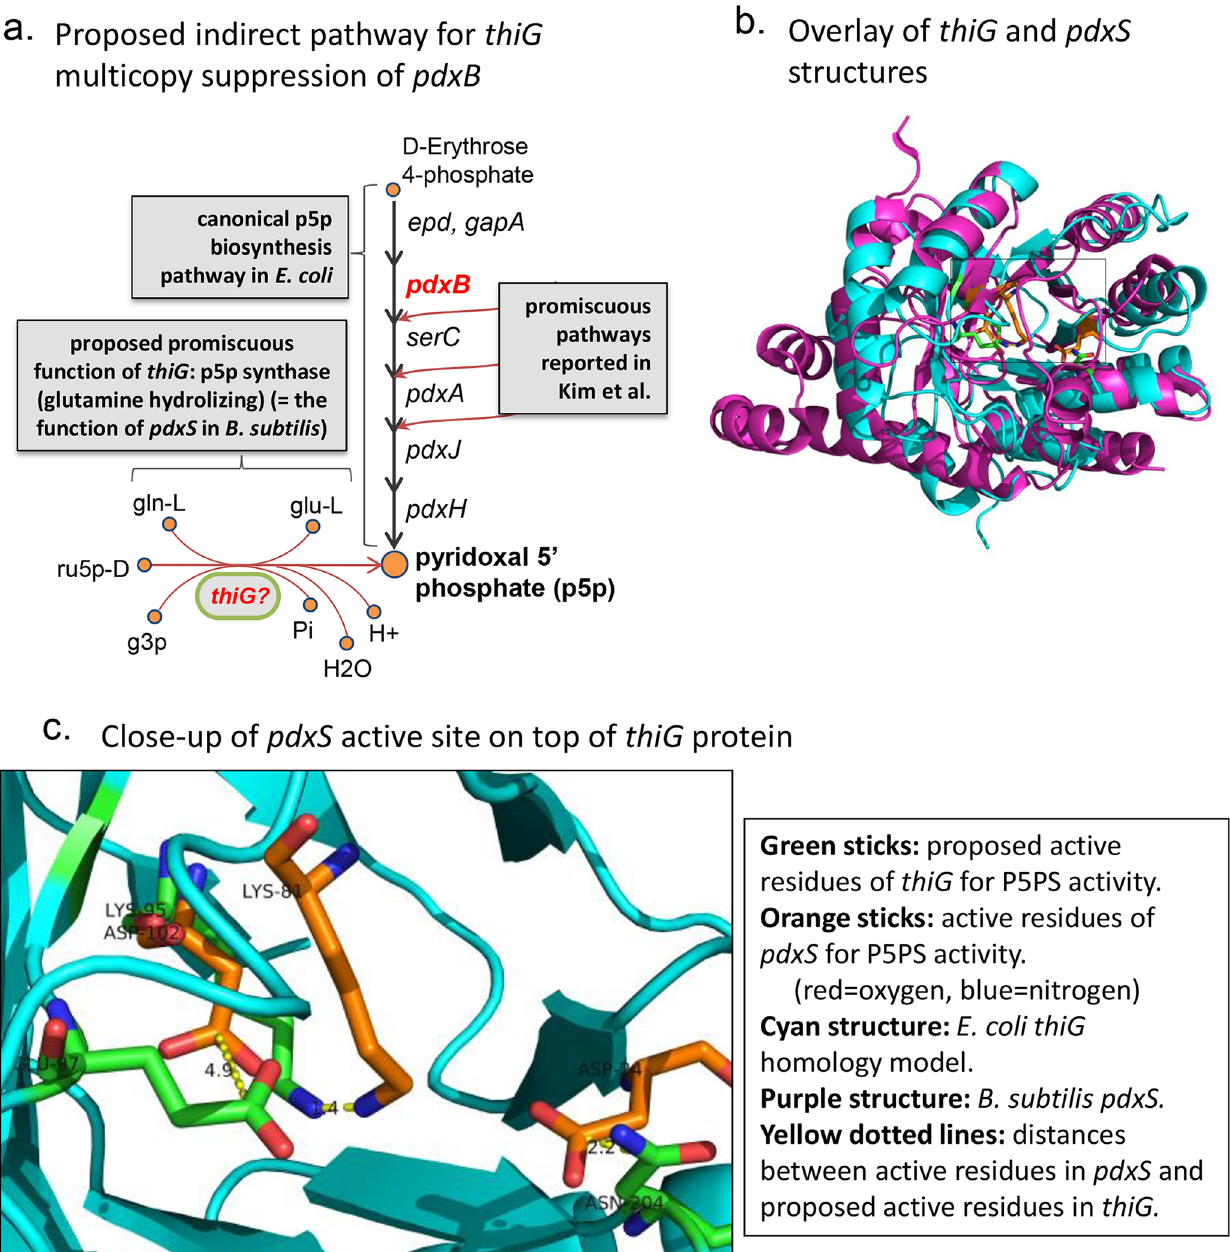
Fig 2. Proposed novel pathway for promiscuous production of pyridoxal 5 ’ -phosphate. GEM-PROPER was used to predict the indirect target-replacer pair, Δ pdxB/thiG , which we then confirmed with experiments. The predicted secondary function of thiG is pyridoxal 5 ’ -phosphate synthase (P5PS), which would bypass the known 6-enzymatic-step pathway for production of p5p in E . coli . (a) The two alternative pathways, along with known promiscuous pathways in E . coli for producing p5p after pdxB knockout (as reported in Kim: [8]). Abbreviations are: ru5p-D = D-Ribulose 5-phosphate; gln-L = L-glutamine; g3p = Glyceraldehyde 3-phosphate; glu-L = L-glutamate; Pi = Phosphate. (b) Structural alignment of a homology model of thiG (for E . coli , based on crystal structure of thiG from B . subtilis ) with a crystal structure of B . subtilis pdxS , the gene that (in complex with another gene, pdxT ) performs the P5PS function in B . subtilis . The proteins share the TIM barrel fold. (c) Close-up of the structural alignment in (b), focused on the active site of pdxS and the residues of thiG that we propose perform the pdxS function. The location of the close-up is shown with a box in (b).